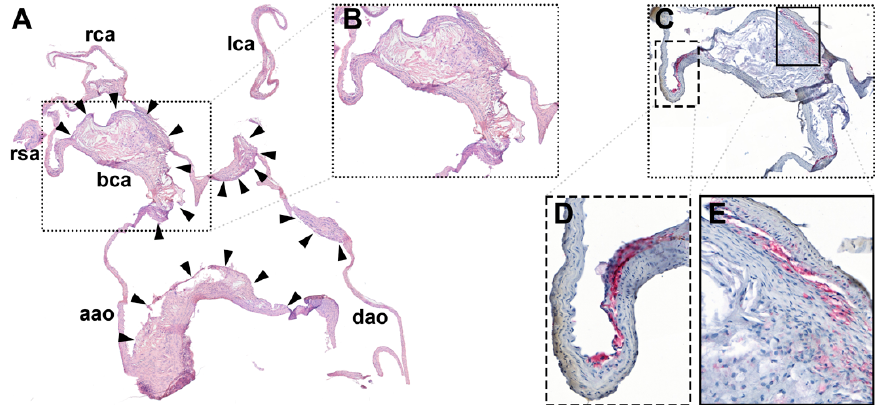
Figure 6. ( A ) Representative HE-stained slice of the aortic arch with the BCA and the left carotid artery. Magnifications of the BCA plaque region (boxes) with ( B ) HE and ( C – E ) MAC3 stains performed on adjacent slices. HE: pink = cytoplasm; blue = nuclei; MAC3: red = macrophages; blue = nuclei and cytoplasm; aao = ascending aortic; dao = descending aorta; bca = BCA; lca/rca = left/right carotid artery; lsa/rsa = left/right subclavian artery; solid arrowheads = BCA plaque; open arrowheads = other plaques.